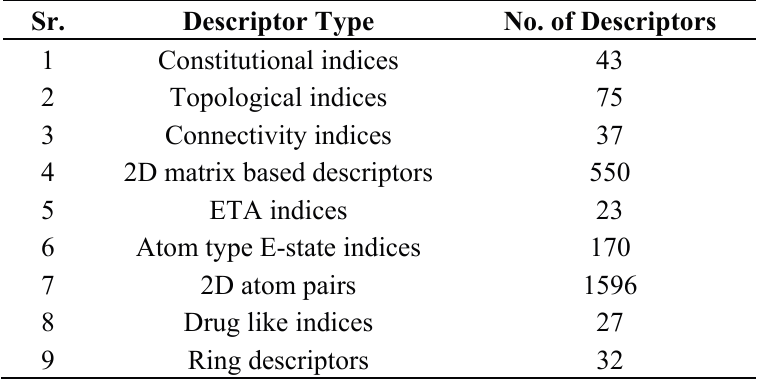
Table 1. Calculated 2D descriptors for 441 Munro database